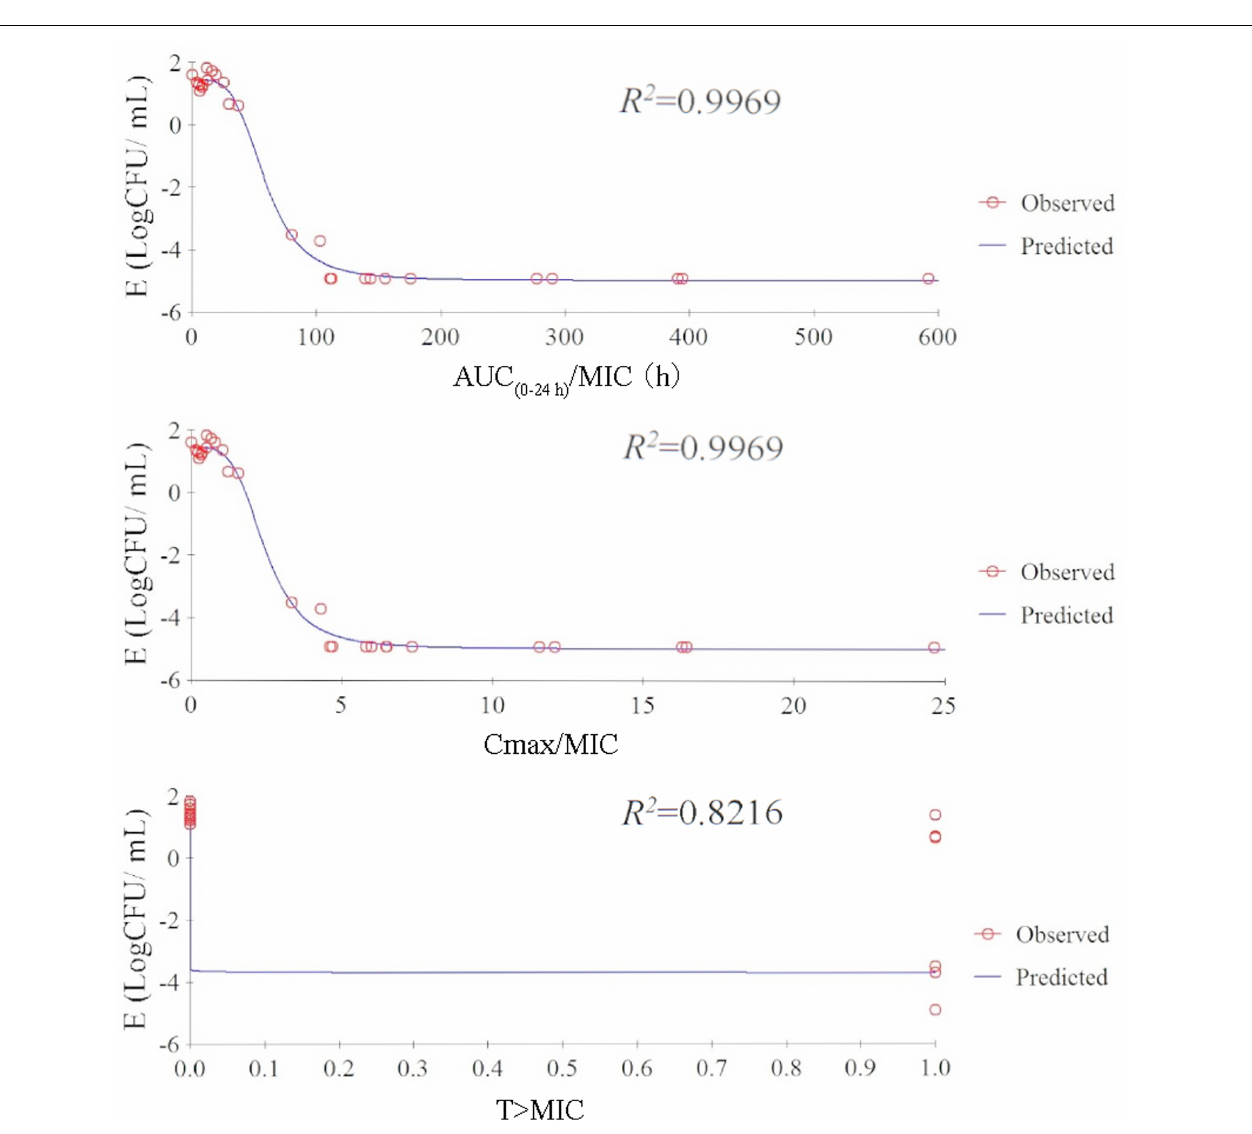
FIGURE 4 | Relationship between PK/PD parameters based MIC for P. multocida and Log10 CFU/mL after 24-h incubation compared with the initial Log 10 CFU/mL by using sigmoid Emax model in serum.